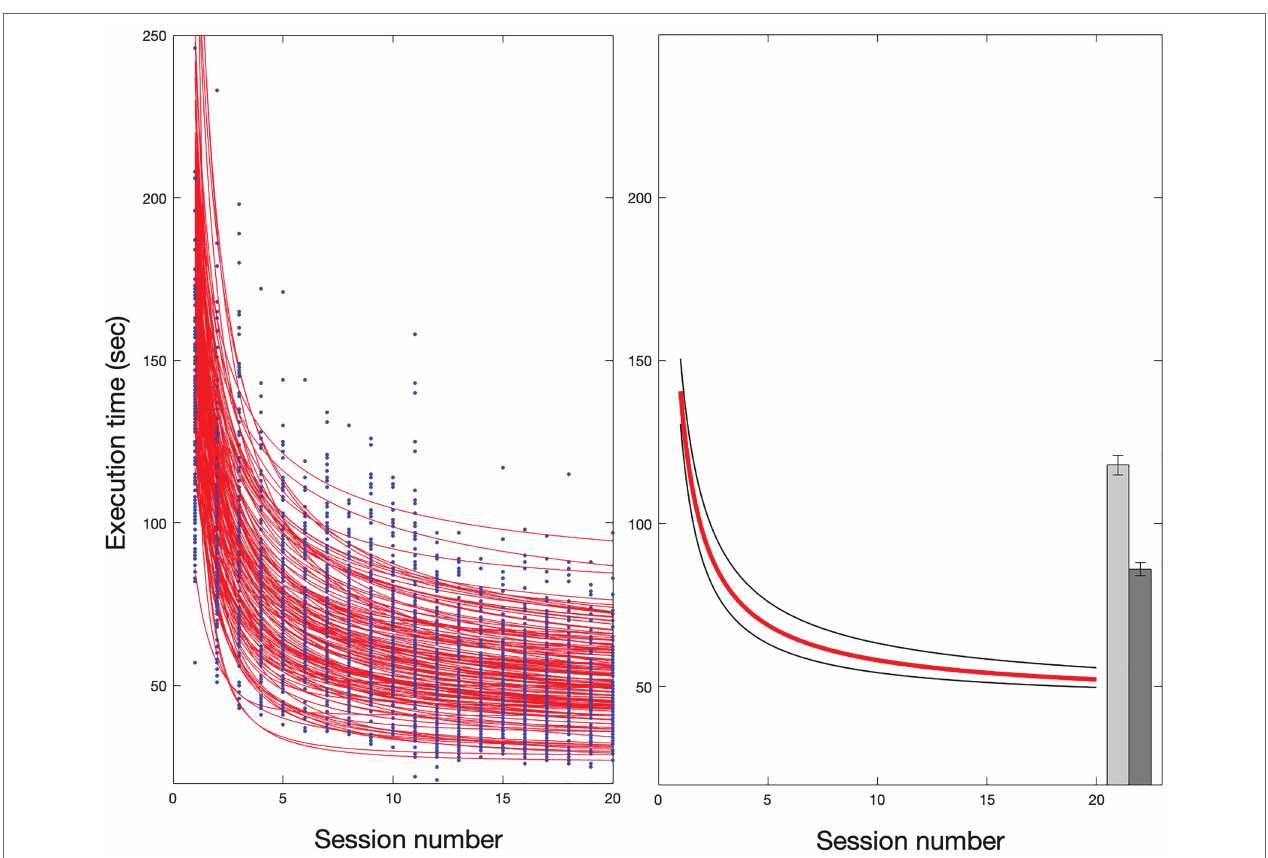
FIGURE 3 | Learning trend in the experimental task. The panel on the left shows the individual fits obtained by the entire sample of 137 children. Twelve fits showed an R 2 < 0.3, and the data were excluded from further analyses. The panel on the right shows the fit applied to the median of the data of the remaining sample of 125 children (red solid line) with an R 2 = 0.95 and the 95% confidence intervals (black lines). The bars on the far right show the medians and standard deviations of the two retest conditions (B1 = 118, SD = 32; B2 = 89, SD =